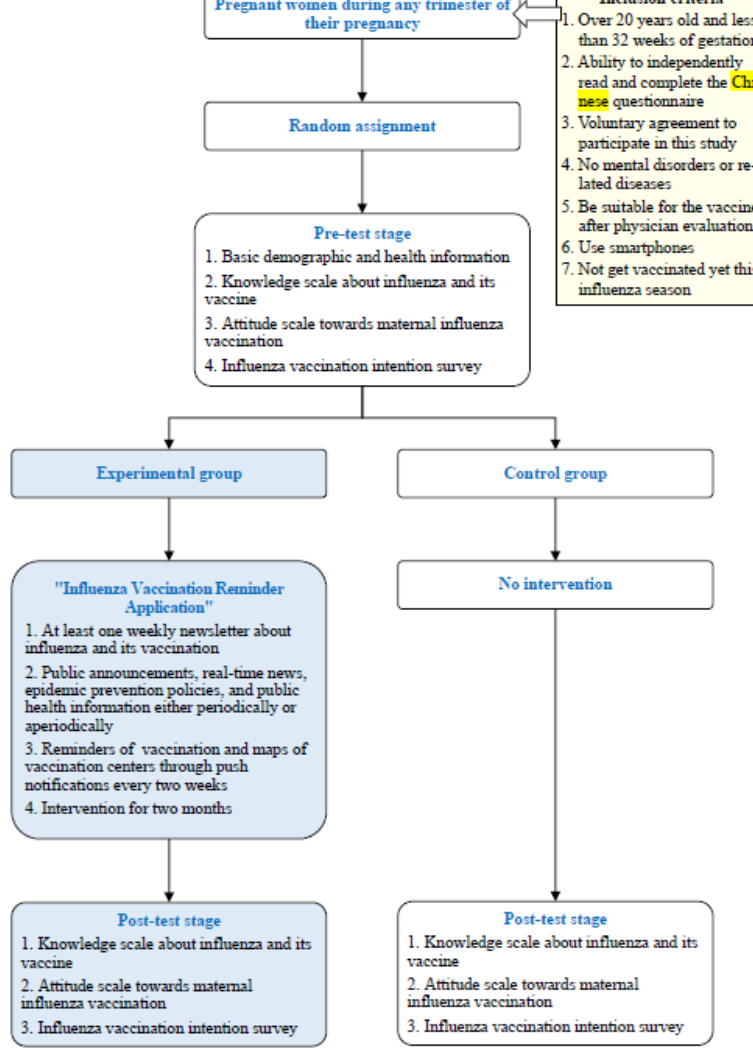
Figure 1. Study procedure.